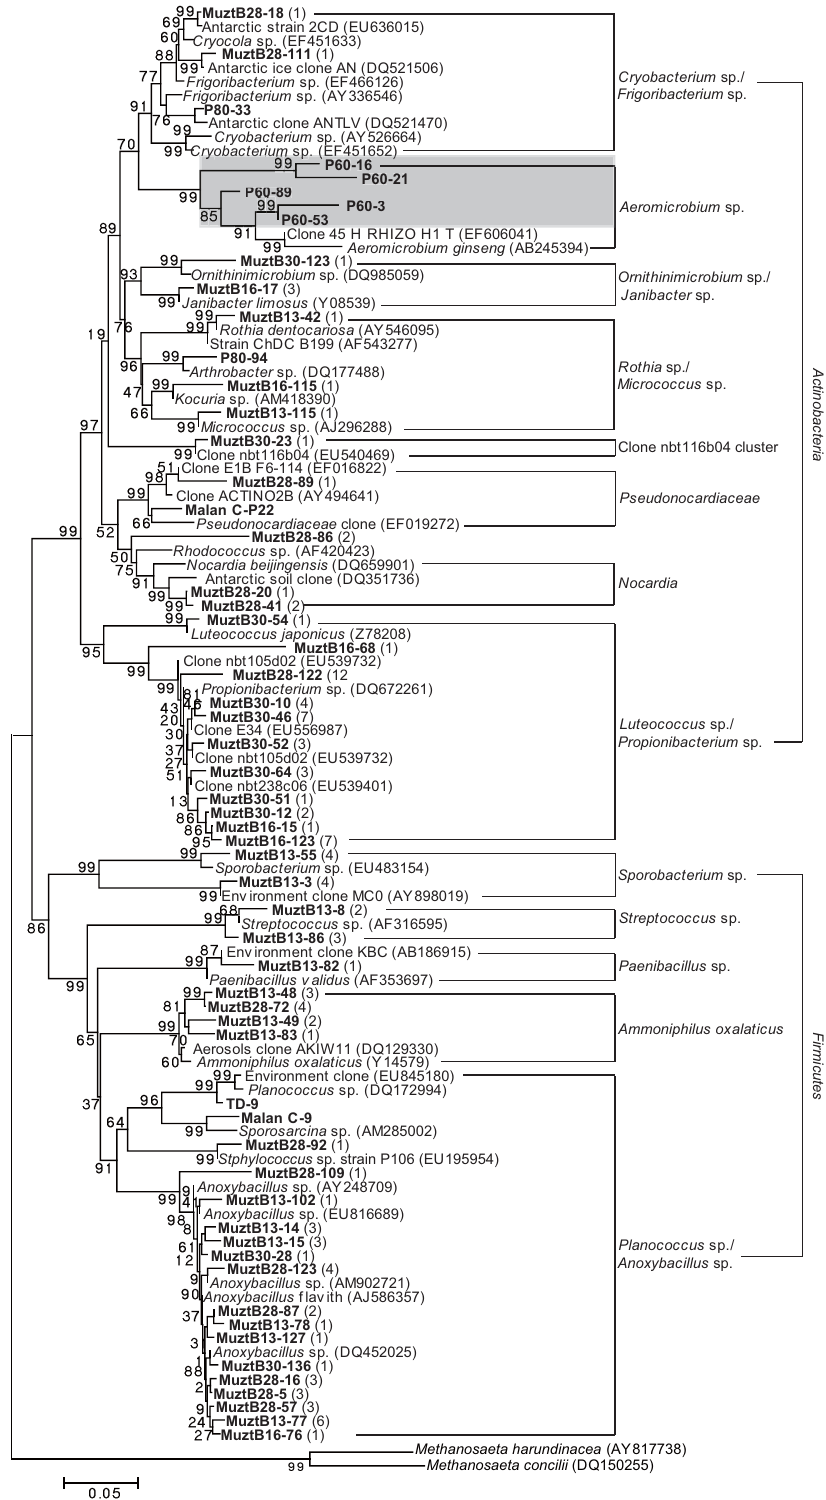
Fig. 3d. Phylogenetic analysis of the 16S rRNA genes for the Actinobacteria and Firmicutes clones from four geographically isolated glaciers and the closest relatives. The tree was constructed by following the protocol as described in Fig. 3a. Scale bar indicated 0.05 substitutions per